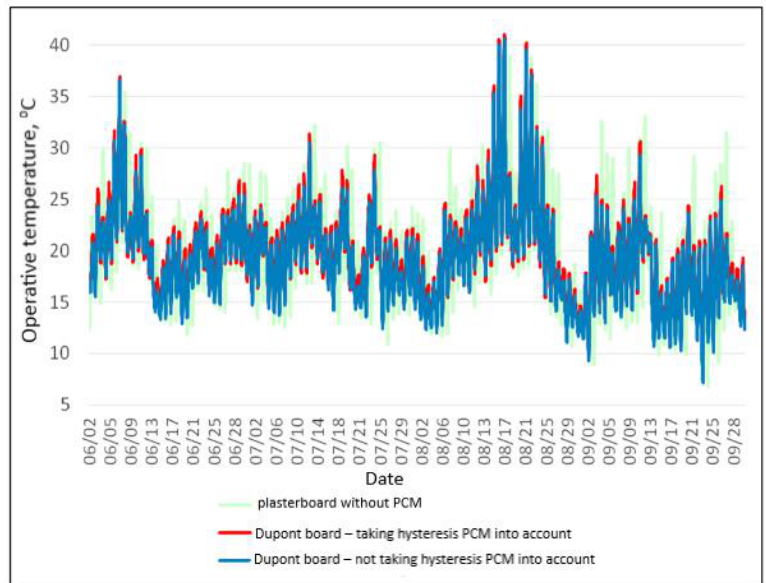
Figure 10. Operative temperature inside the analyzed building with Dupont boards.